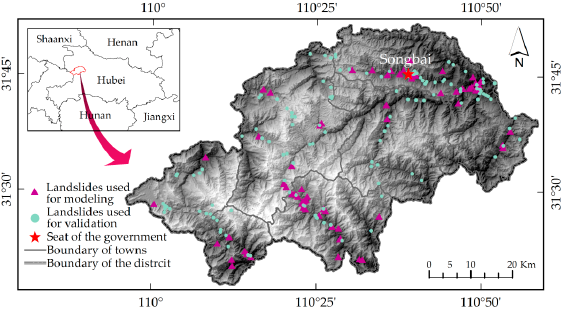
Figure 1. Location map of the Shennongjia Forestry District (provided by the Land Resources Bureau of Shennongjia). Table 1. List of data sources used in the